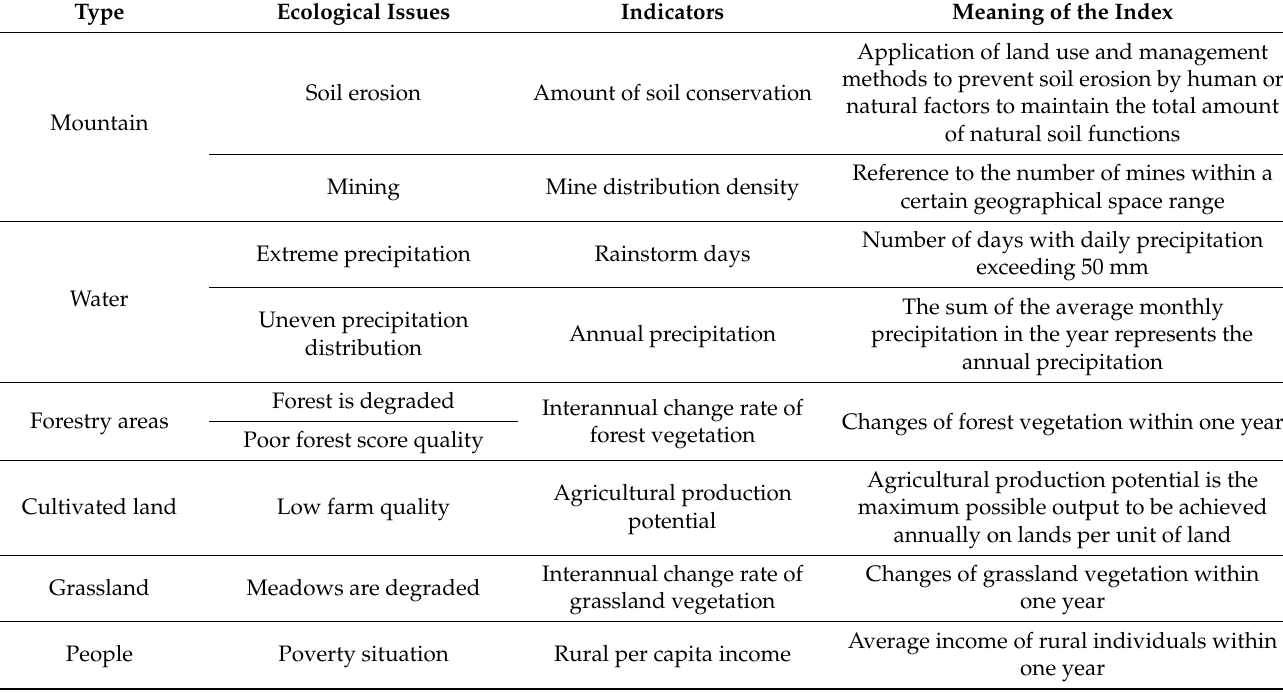
Table 1. Diagnosis index system of mountains, forestry, fields, lakes, and grassland ecology systems in the Qilian Mountains.